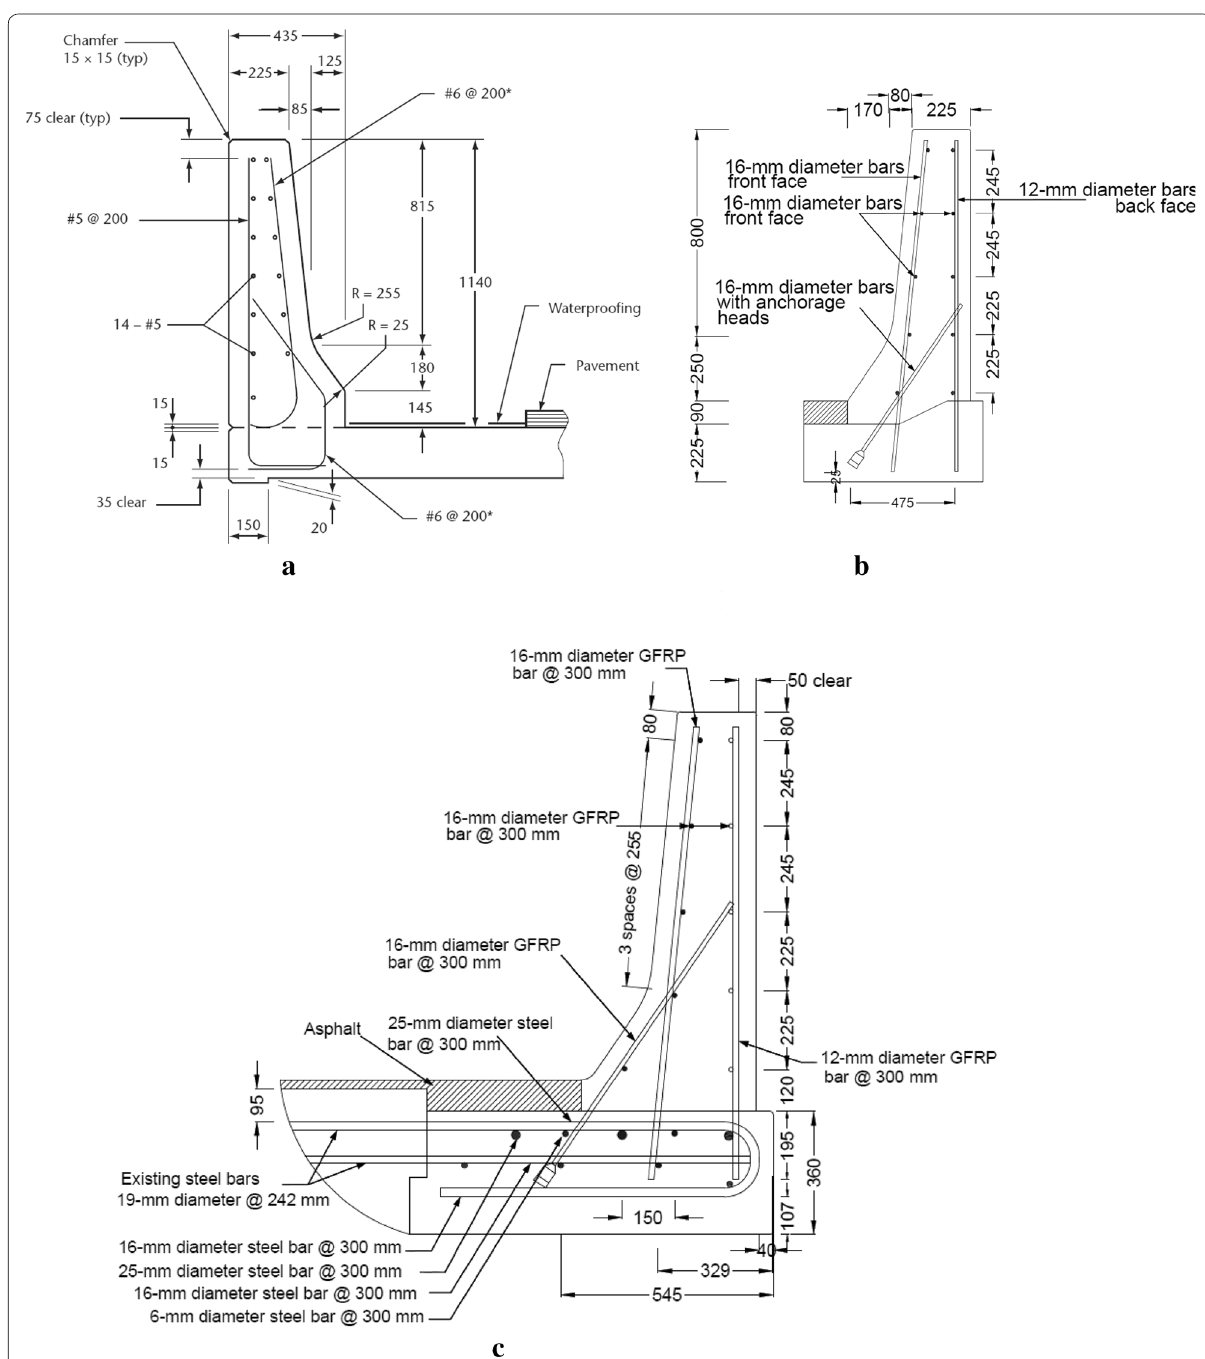
Fig. 2 Schematic diagram of the reinforcement for the proposed barrier and constructed barrier–deck system. a CHBDC barrier with low-modulus GFRP bars, b proposed barrier with high-modulus GFRP bars, c constructed GFRP-reinforced barrier over deck slab cantilever anchored to an existing foundation